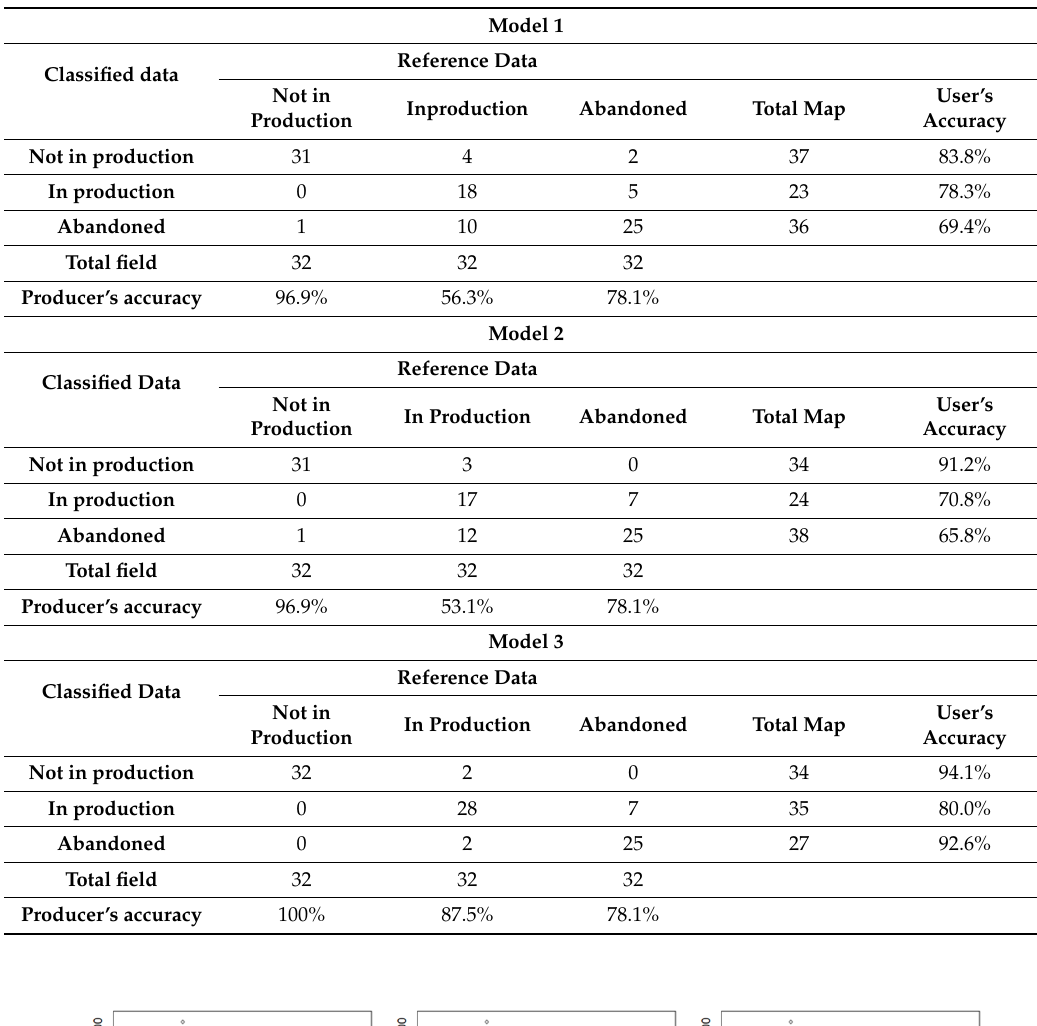
Table 5. Model confusion matrix.